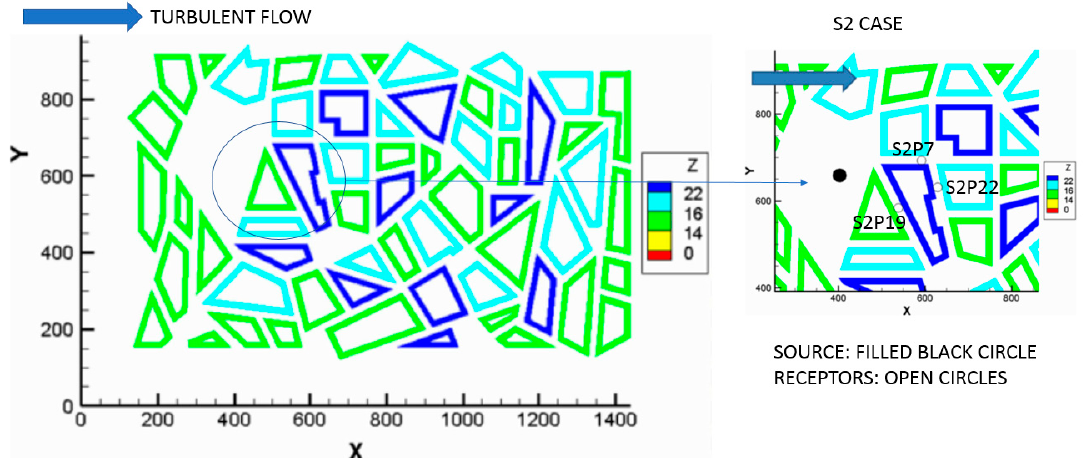
Figure 2. Top view of the buildings configuration in the Michelstadt wind-tunnel experiment ( left ); source and receptors locations for the S2 Michelstadt puff experiment ( right ).